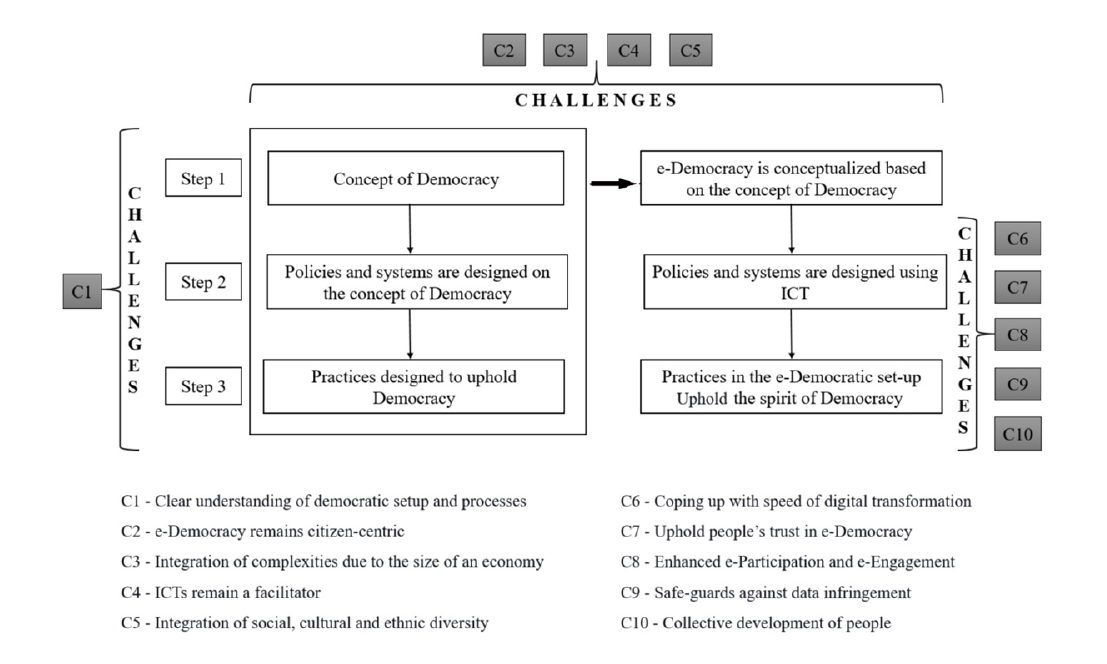
Fig. 2: The institutionalization of